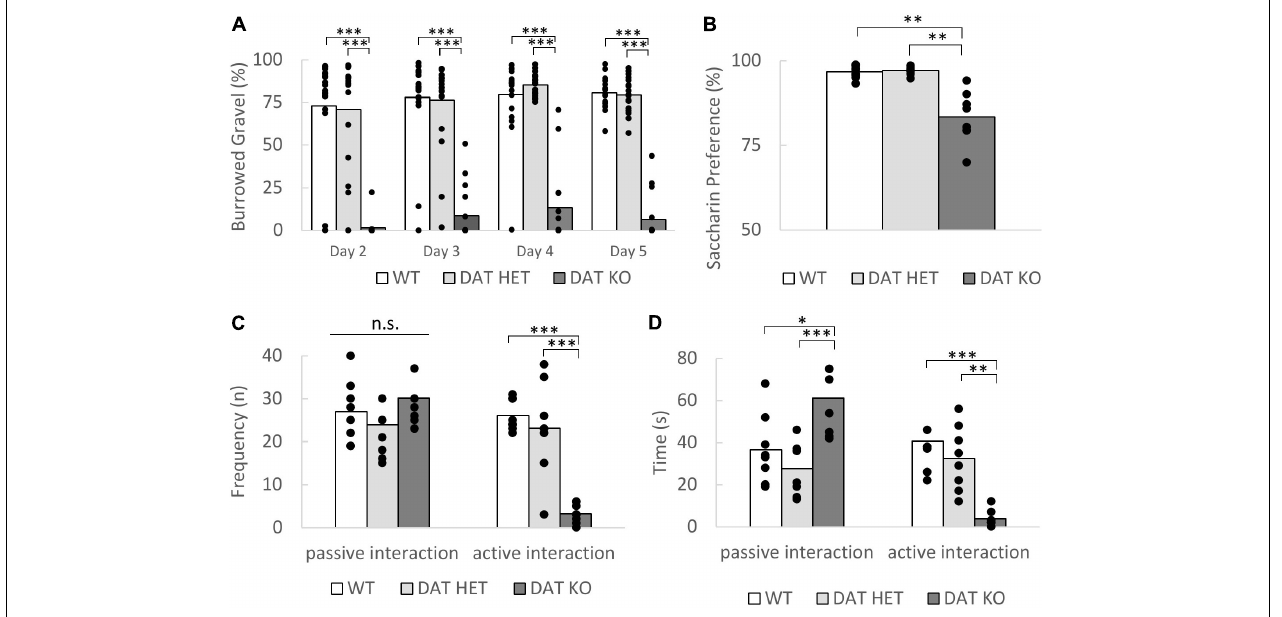
FIGURE 2 | (A–D) Wellbeing parameters. (A) Burrowing test. The burrowed gravel in percentage over the training week is expressed as the mean. The DAT KO rats burrowed significantly lower amounts of gravel on all days. Sample Size: DAT KO ( n = 16), DAT HET ( n = 20), WT ( n = 20). (B) Saccharin preference test. The bars show the mean preference of the saccharin solution over water over both testing days. The preference for the saccharin solution is significantly lower for the DAT KO rats. Sample Size: DAT KO ( n = 8), DAT HET ( n = 10) and WT rats ( n = 10). (C,D) Social interaction. (C) Frequency of passive and active interactions shown during the first 5 min of the social interaction test. The DAT KO rats displayed less active interactions compared to the DAT HET and WT rats. No differences were observed in the frequency of passive interactions. (D) Duration of the shown active and passive interactions shown during the first 5 min of the social interaction test. The DAT KO rats spent significantly more time interacting passively and less time with active interactions compared to the two other genotypes. (C,D) Data are expressed as the mean + SEM. Sample size for all genotypes n = 8. (A–D) The dots in the bar graphs indicate all included data points in the analysis. ∗ p < 0.05, ∗∗ p < 0.01, and ∗∗∗ p <